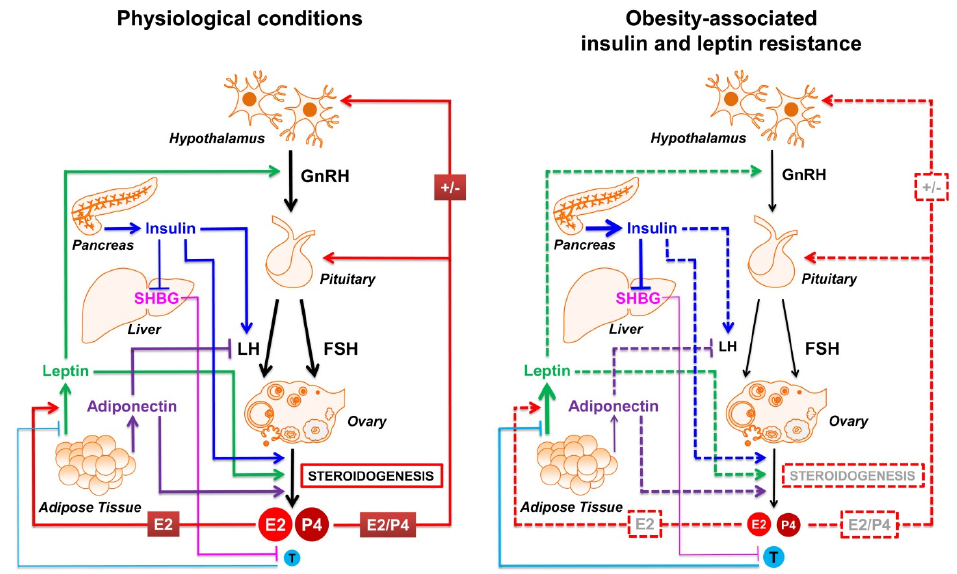
Figure 2. Effects of insulin, leptin and adiponectin on the regulation of hypothalamic pituitary gonadal axis (HPG) and steroidogenesis under physiological and obesity-associated conditions. Under physiological conditions ( left ) the signaling pathways of insulin, leptin and adiponectin are able to sense the nutritional status, and, jointly with sex hormones sustain ovarian activity and reproduction. In obesity ( right ), the increased levels of insulin and leptin lead to insulin and leptin resistance that, together with the reduced adiponectin levels, contribute to a dysregulation of both the HPG axis and ovarian steroidogenesis, by further worsening the endocrine milieu (impaired E2 and P4 synthesis, increased T synthesis and free levels due to reduced SHBG synthesis) and impairing ovarian function and fertility success rate. In the figure the dotted lines represent impaired regulations. E2 = 17 β -estradiol; P4 = progesterone; T = testosterone.